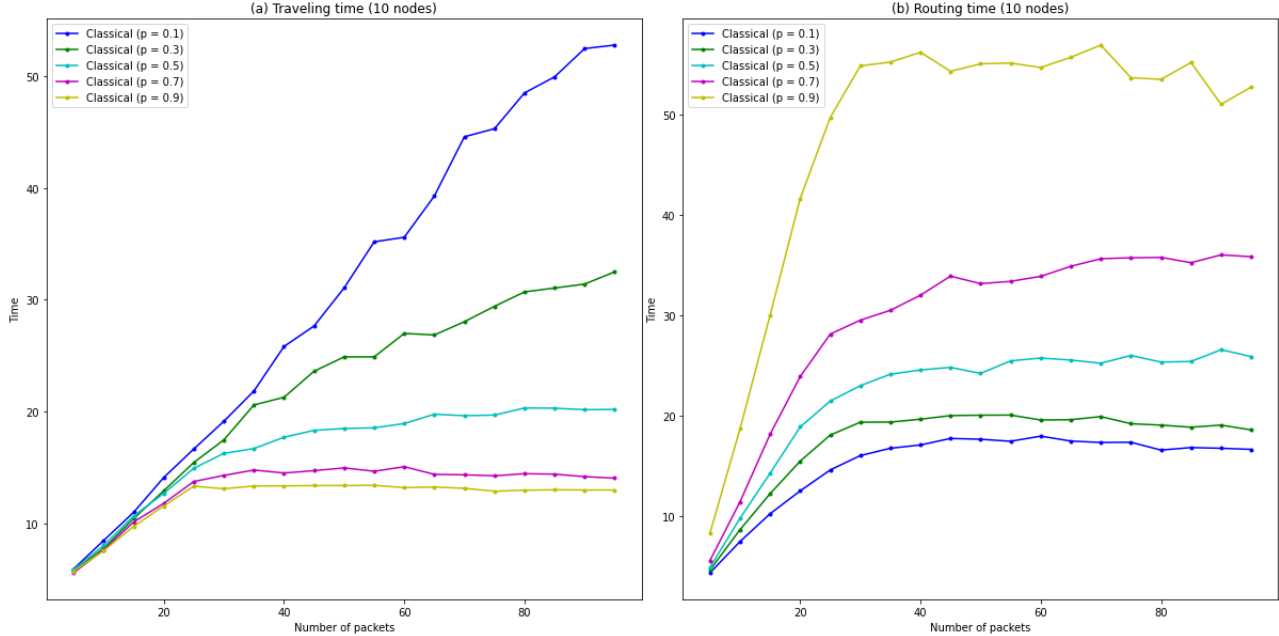
Figure 3. Graphs for different probabilities p of: ( a ) Traveling time as a function of the number of packets. ( b ) Routing time as a function of the number of